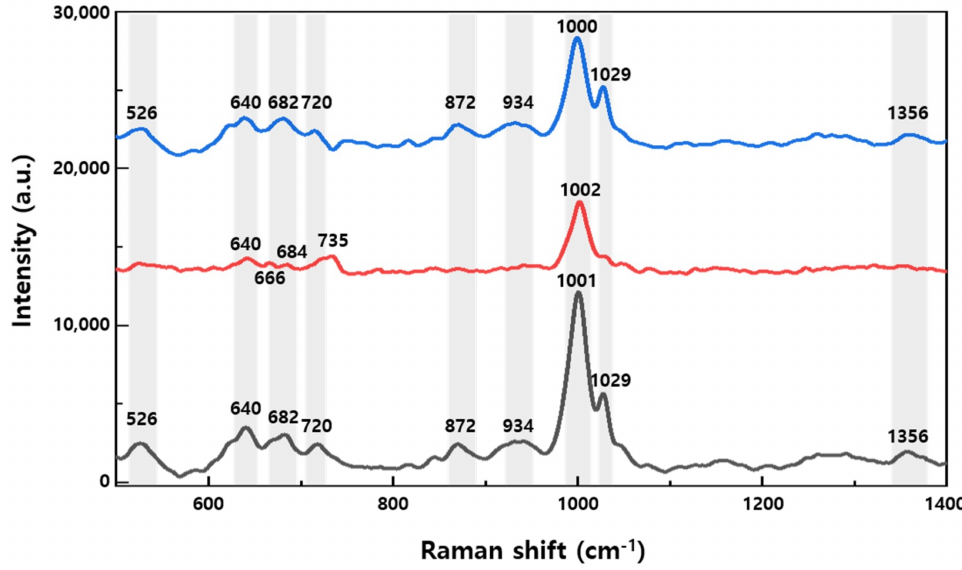
Figure 4. SERS spectra of healthy rat urine measured using 100 nm Au (black curve) and 200 nm Au (red curve) substrates. The blue curve shows the corresponding difference in spectra between the 100 nm gold SERS substrate and the 200 nm gold SERS